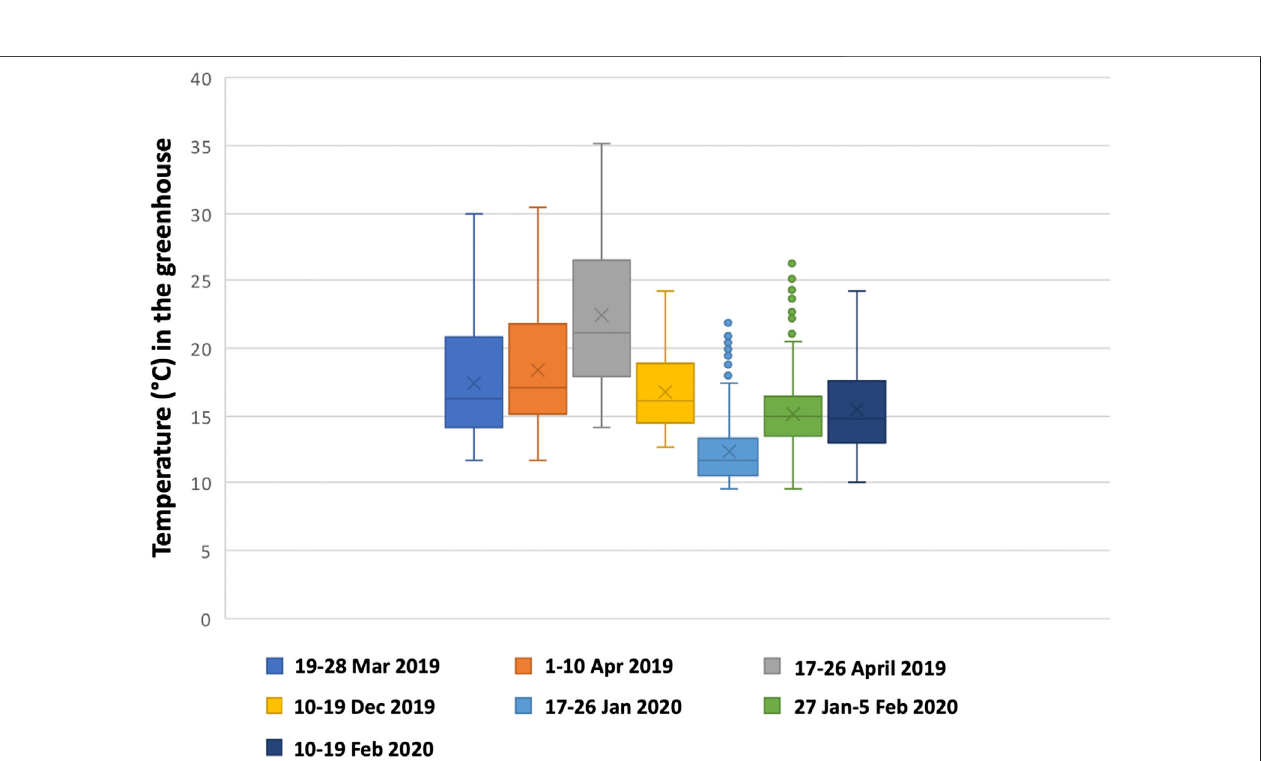
Frontiers in Bioengineering and Biotechnology | www.frontiersin.org June 2022 | Volume 10 | Article 896261